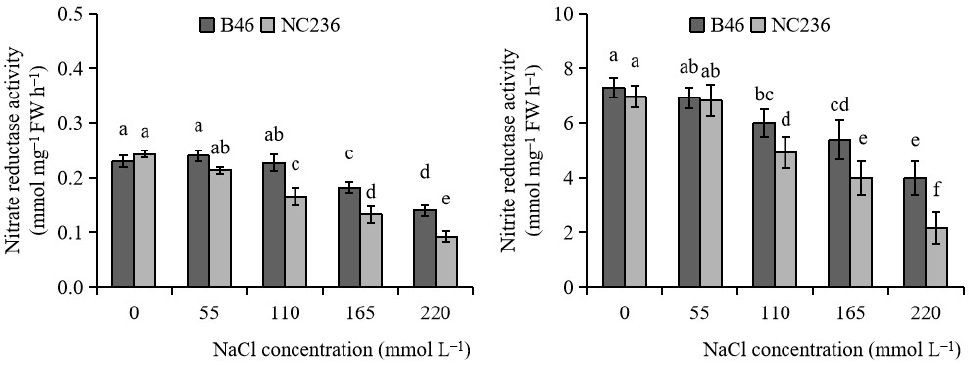
Figure 6. Effects of salt stress on the activities of nitrate reductase and nitrite reductase in maize leaves. Data are expressed as mean ± standard deviation. Different letters within the same column indicate significant difference at the 5% level.